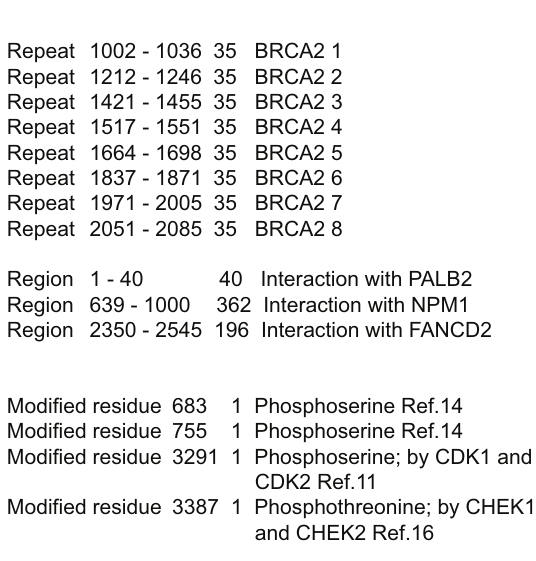
Figure S2. Annotating the hbrca sequence. The syntax is similar to the one used in the UNIPROT accession